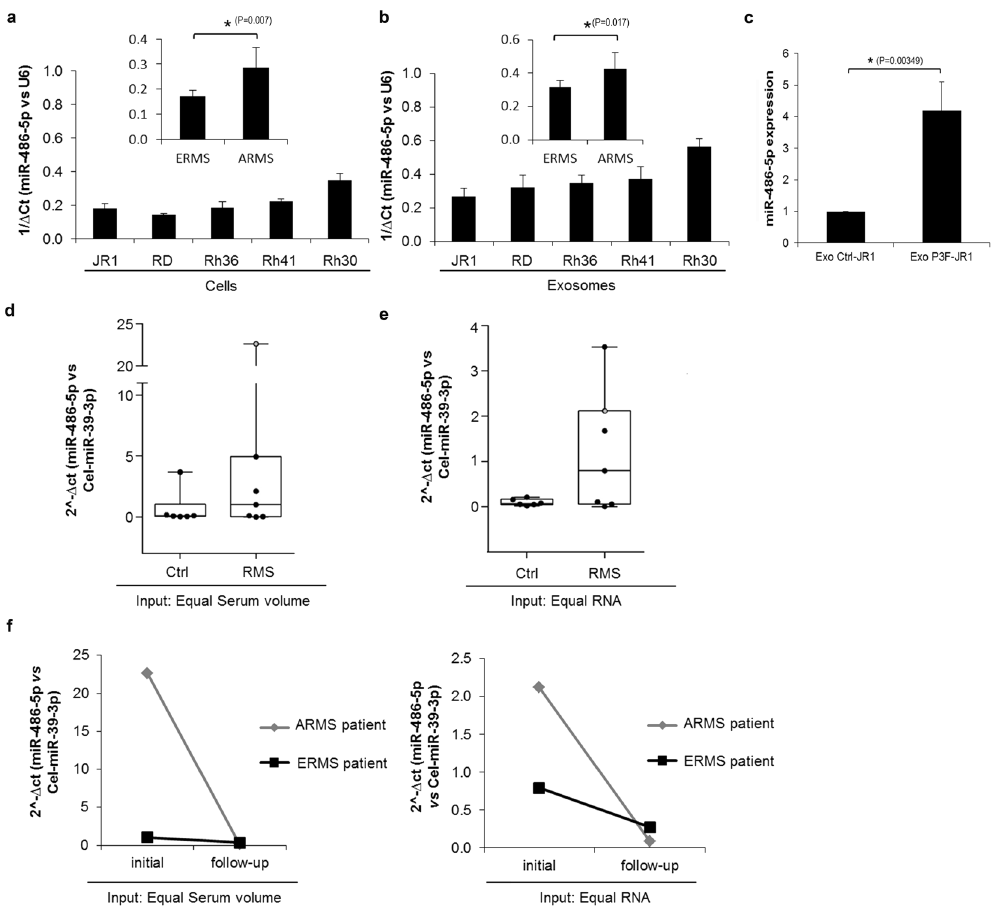
Figure 6. miR-486-5p expression in human RMS cells and patient serum samples. ( a , b ) qRT-PCR of miR- 486-5p expression in ( a ) human RMS cell lines and ( b ) their derived exosomes, normalized to U6 expression. ( c ) miR-486-5p levels in exosomes isolated from P3F-JR1 cells versus those from Ctrl-JR1 cells, normalized to U6 expression as detected by qRT-PCR analysis. Values presented are means of three independent experiments. Bars represent standard deviation. Asterisks denote a statistically significant difference. ( d – e ), qRT-PCR analysis of miR-486-5p in exosomes isolated from the serum of 7 patients with RMS (6 ERMS and 1 ARMS labeled in grey) compared to those from control subjects with benign tumors (n = 6) starting with either ( d ) equal serum ( p-value = 0.51 ) or ( e ) equal RNA amounts ( p-value = 0.18 ). C. elegans miR-39-3p spike-in control was used for normalization ( f ) Exosomal miR-486-5p levels in follow-up serum of ARMS and ERMS patients compared to initial serum collected at diagnosis. Equal serum volume (left panel) or equal RNA (right panel) was used as input, and C. elegans miR-39-3p spike-in control was used for